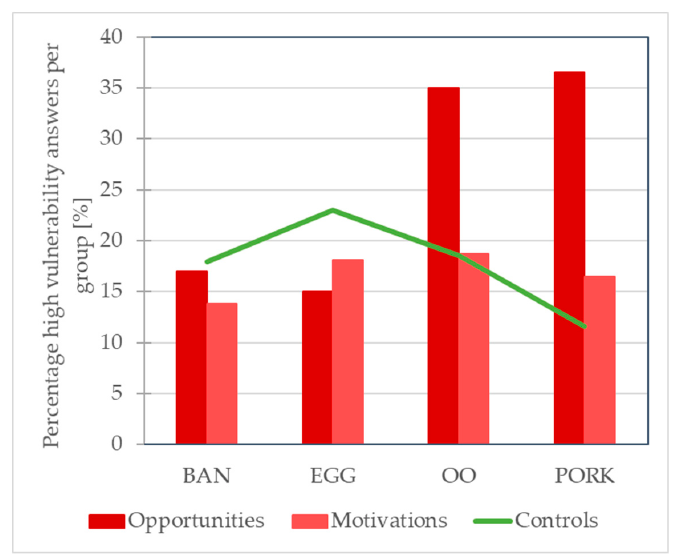
Figure 1. Relative frequencies of high vulnerability answers to the questions associated with the three key elements (opportunities, motivations, controls) provided by the banana (BAN), egg (EGG), olive oil (OO) and pork (PORK) supply chain actors. Table 1. Relative frequencies of high vulnerability answers to questions associated with the three key elements and provided by the individual supply chain actors: opportunities, motivations and controls. The occurrence of high vulnerability answers is indicated by the red color intensity of the cells. Actor